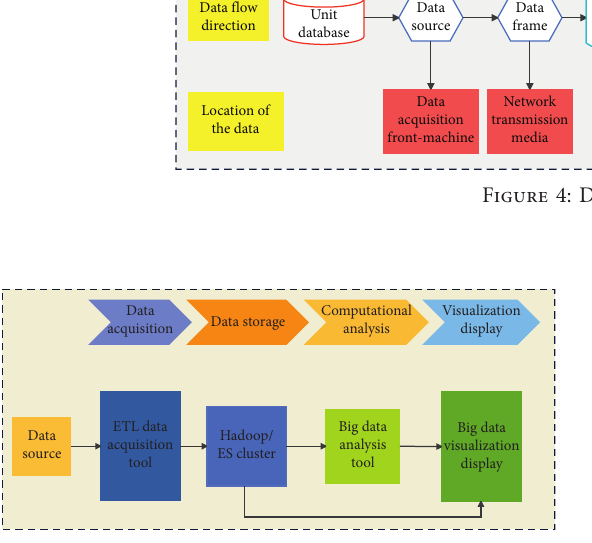
Figure 5: Schematic diagram of system processing flow.